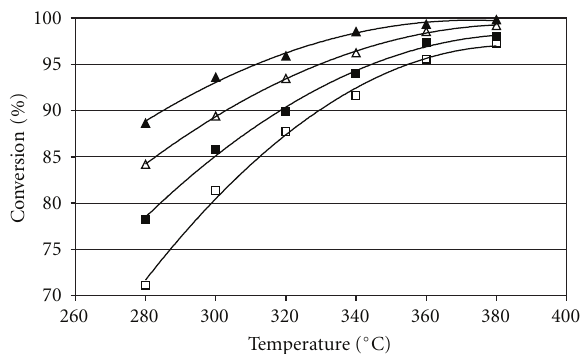
Figure 4: Yield of the INPRP as a function of the temperature and the LHSV; where: -0.75 h − 1 , Δ -1.0 h − 1 , (cid:4) and -3.0h − 1 of LHSV ( P = 80bar, H 2 /waste lard volume ratio = (cid:2) 600Nm 3 /m 3 ).